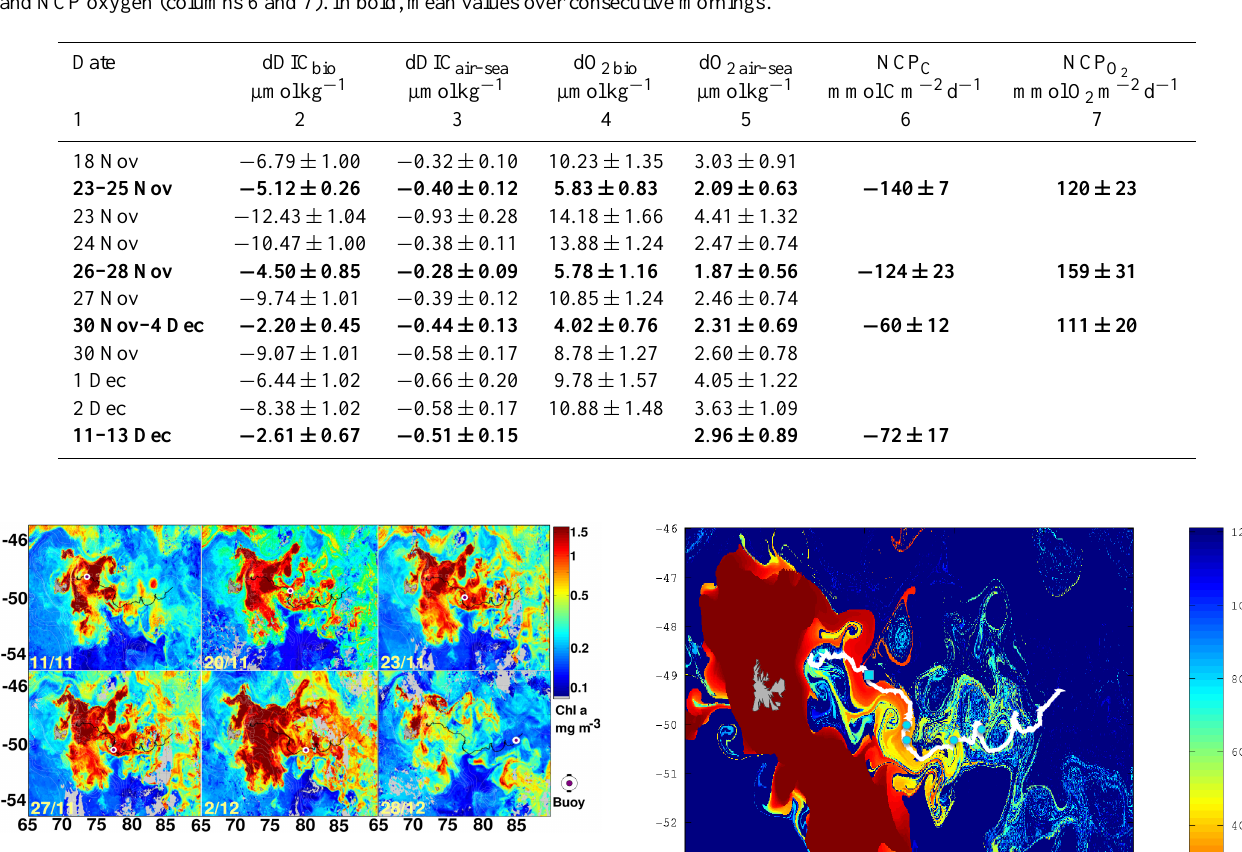
Figure 3. Spatial extent of phytoplankton blooms over and down- stream from the Kerguelen Plateau as revealed by satellite ocean color on 6 selected days, between 11 November and 28 Decem- ber 2011. The trajectory followed by the CARIOCA drifter is super- posed on the chlorophyll patches (black line). The circles indicate the location of the buoy the same days.